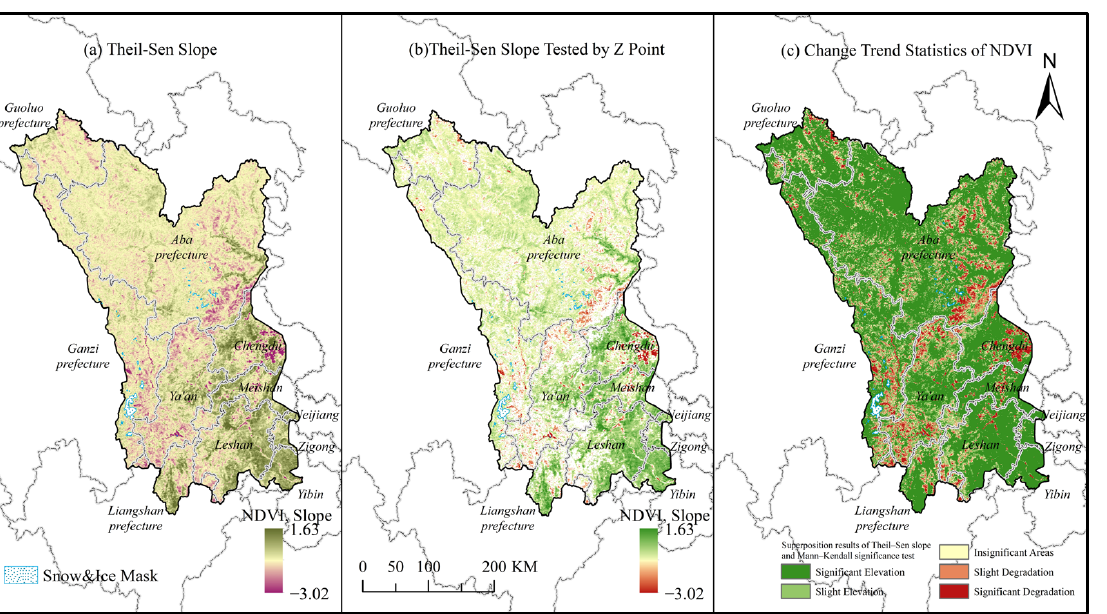
Figure 4. Spatial distribution of Theil–Sen slope of average NDVI in the growing season in the Minjiang River Basin from 2001 to 2020 and the superposition result with Mann–Kendall test.